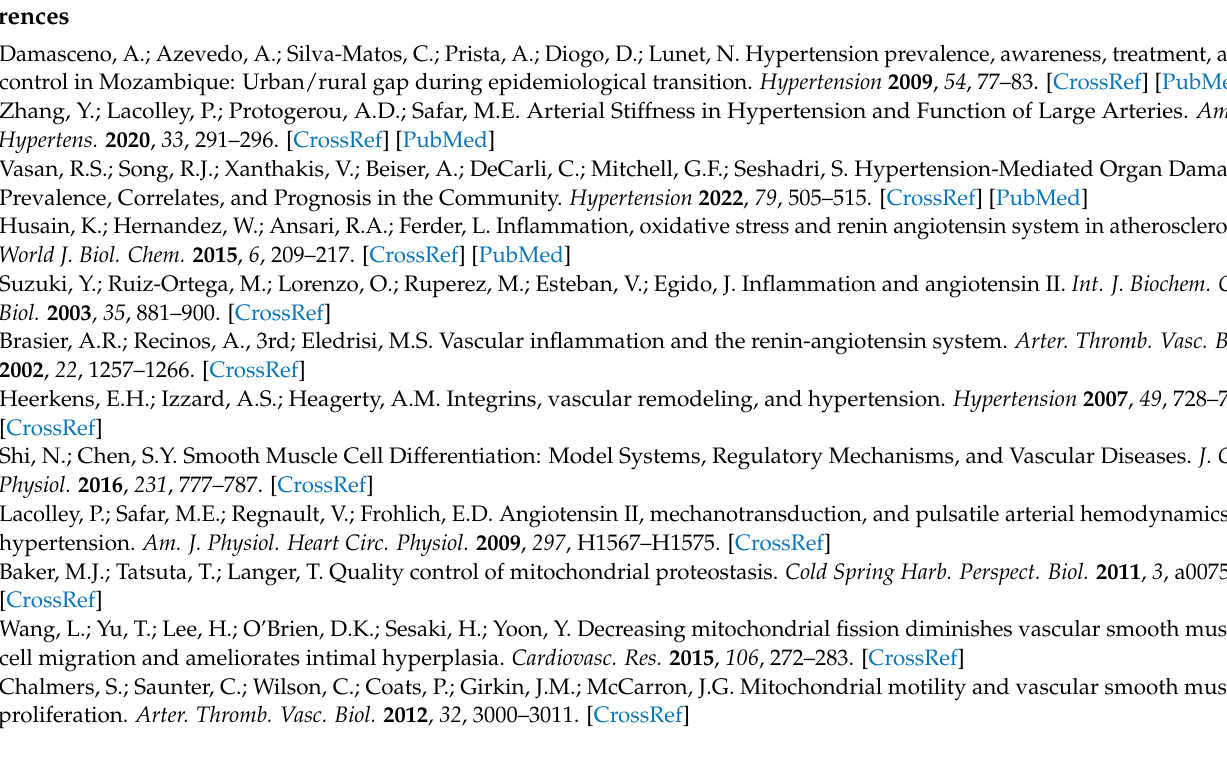
Table S2. Primer sequence; Figure S1. The metabolic general parameters of Ppara ∆ SMC and Ppara fl/fl mice; Figure S2. PPAR α deficiency in VSMCs aggravated Ang II-induced the vascular elevation of Nox4 . Figure S3. Activation of PPAR α by Wy14643 had no effect on Ang II-induced cardiac